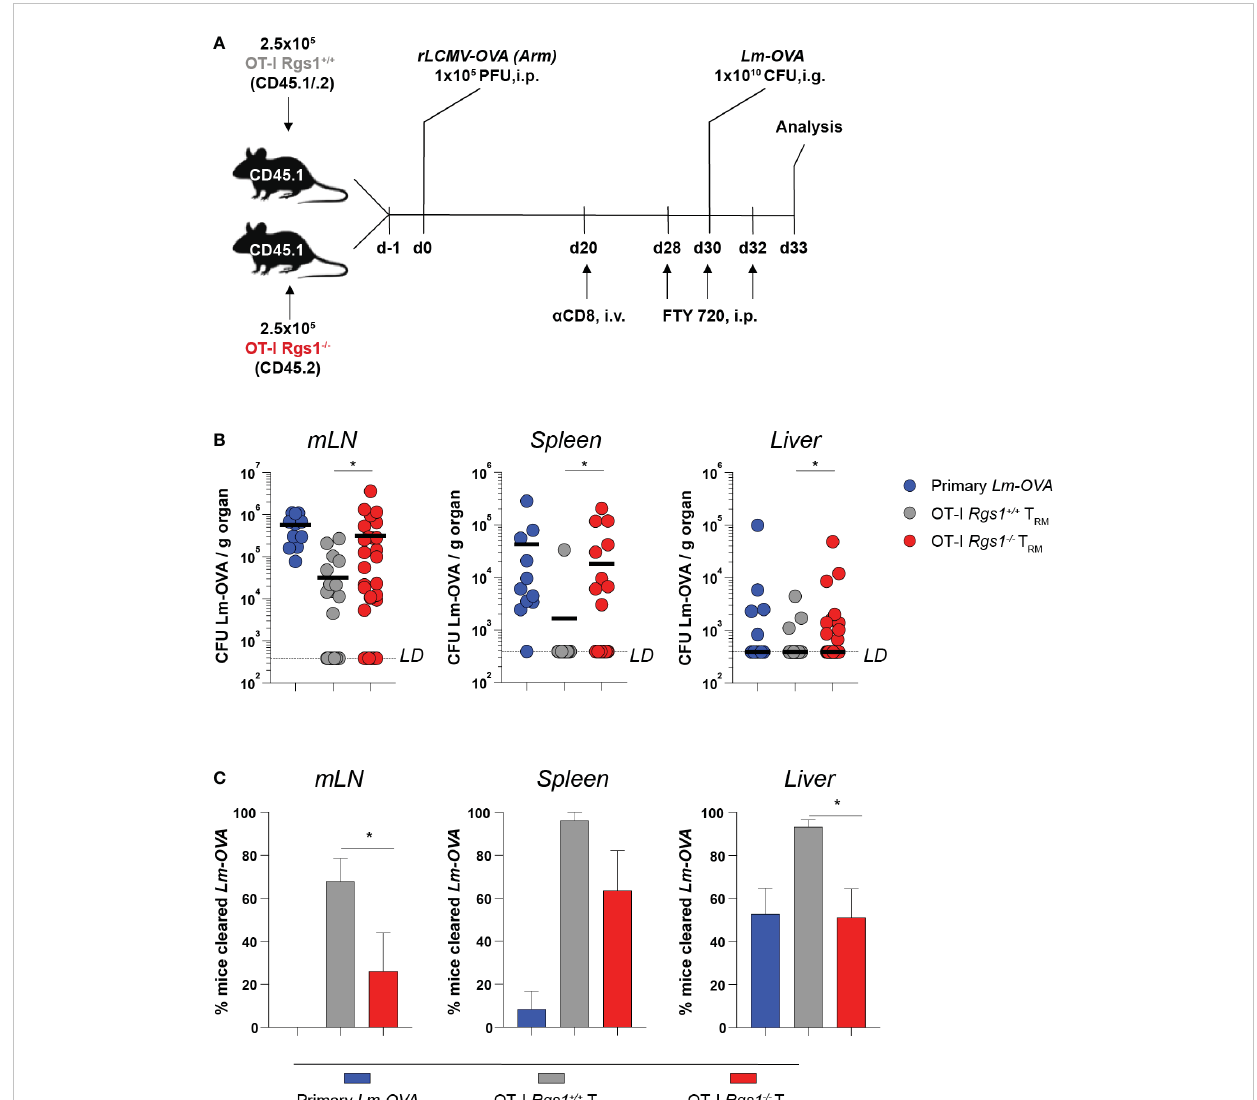
FIGURE 6 Rgs1 -de fi cient CD8 + T RM cells in the small intestine confer impaired protection from systemic pathogen dissemination upon local infection with Lm- OVA . (A) Experimental set-up. (B) Lm-OVA titers, measured on day 3 post re-challenge in the mLN, spleen, and liver of control mice without transferred OT-I T cells and without rLCMV-OVA infection on d0, but infection with Lm- OVA on d30 ( “ primary Lm-OVA ” , blue, n=11); mice with intestinal wild type OT-I T RM cells ( “ OT-I Rgs1 +/+ T RM ” , grey, n=25-28) and mice with intestinal Rgs1 -/- OT-I T RM cells ( “ OT-I Rgs1 -/- T RM ” , red, n=30- 31). Titers of the OT-I Rgs1 -/- T RM group were compared to the OT-I Rgs1 +/+ T RM group (individual values + mean, LD (limit of detection was calculated as the hypothetical smallest detectable Lm-OVA colony count (=1) in the largest collected piece of organ), unpaired Mann-Whitney t -test, two-tailed, * p < 0.05. (C) Percentage of mice in the “ primary Lm-OVA ” , “ OT-I T RM ” and “ OT-I T RM Rgs1 -/- ” groups with non-detectable Lm-OVA (Lm cleared) in the indicated organs. Means of 3 independent experiments (each with n=7-13 per group) between the “ OT-I T RM ” and “ OT-I Rgs1 -/ - T RM ” groups were compared (mean ± SEM, unpaired Student´s t -test, two-tailed, * p <